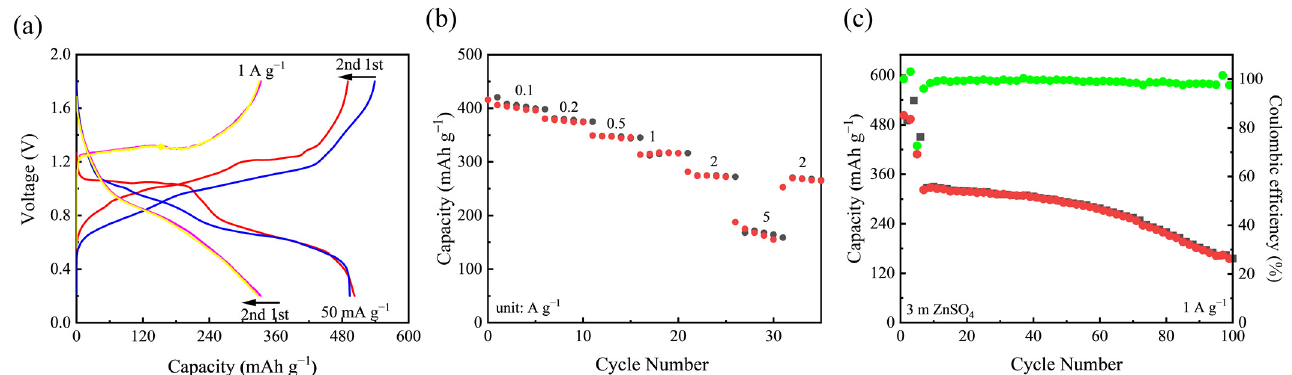
Figure 6. ( a ) GCD profiles of the Zn/V 2 O 5 · n H 2 O cell using Zn powders as the anode at 50 mA g − 1 and 1 A g − 1 for the 1st and 2nd cycles. ( b ) Rate performance of the Zn/V 2 O 5 · n H 2 O cell at current densities from 0.1 to 5.0 A g − 1 . ( c ) Cycling performance of the cell at 1.0 A g − 1 . The cell was initially cycled at 0.05 A g − 1 for three cycles as an activation step.